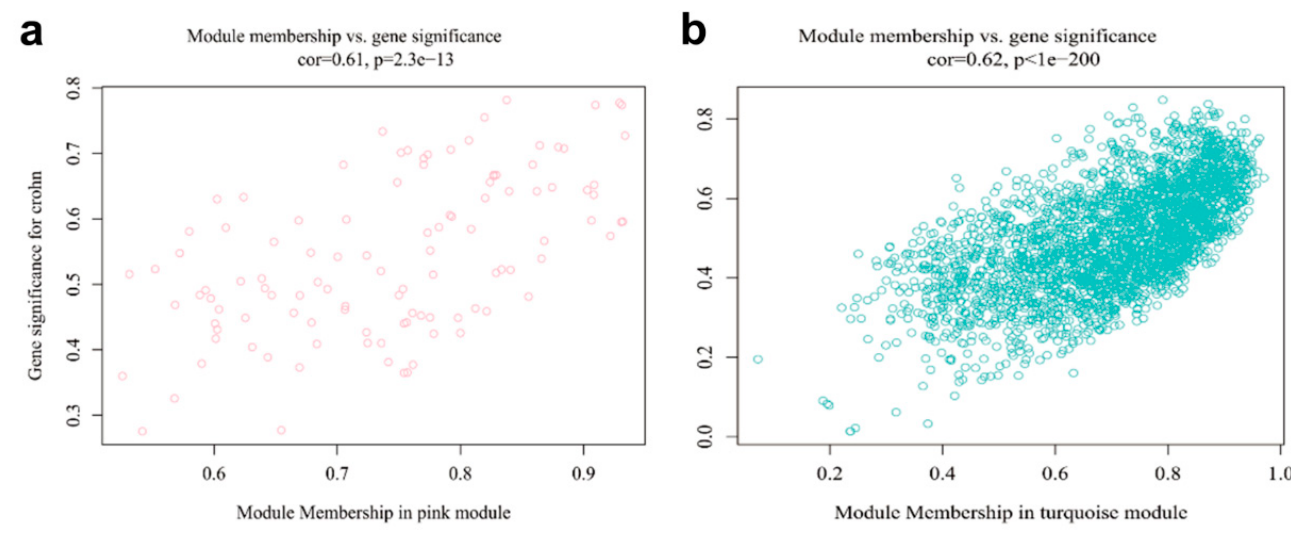
Figure 8. Scatter diagram of gene significance for Crohn’s disease and module membership in the ( a ) pink and ( b ) turquoise modules. Gene significance (GS) is defined as the association of a single gene with external information, and module membership (MM) is calculated based on GS values. When a gene is highly correlated with a trait, the module in which this gene is located is also highly correlated with this